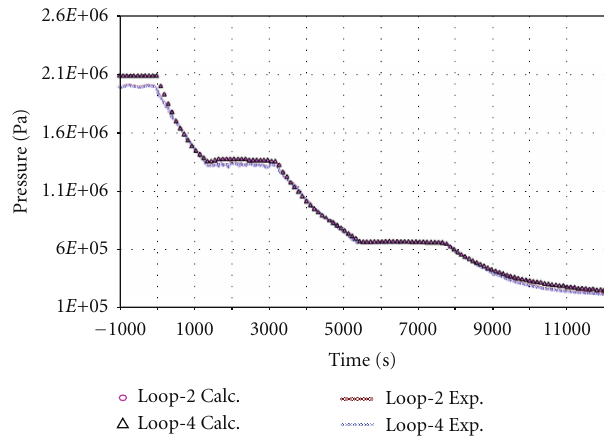
Figure 15: Run-3: Cold and hot leg temperature evolution in the active loops.